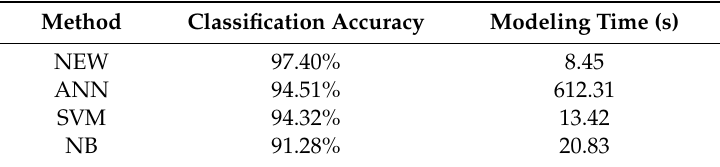
Table 8. The performance of di ff erent